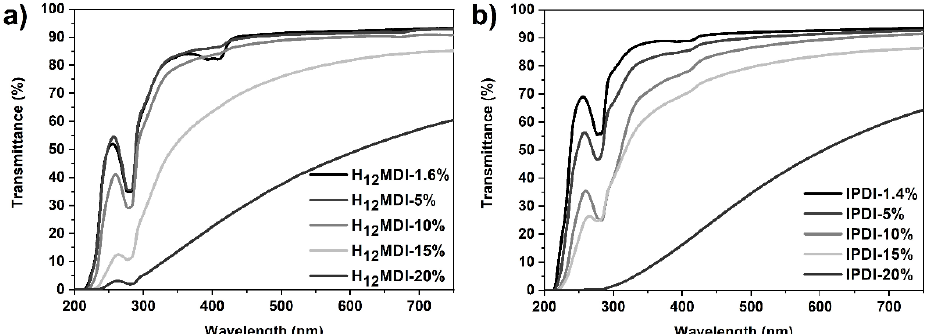
Figure 3. UV–Vis spectra of PSU elastomers synthesized from ( a ) H 12 MDI and ( b ) IPDI with HS